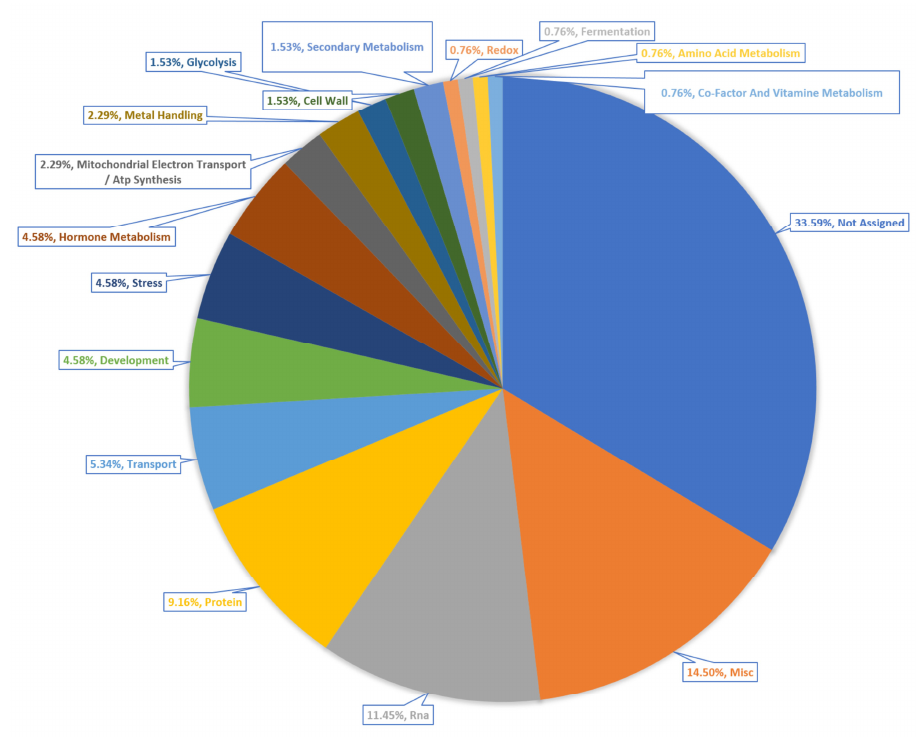
Figure 10. Enriched biological pathways from the 131 DEGs shared by Col-0, Cvi-0, and U112-3 ecotypes.